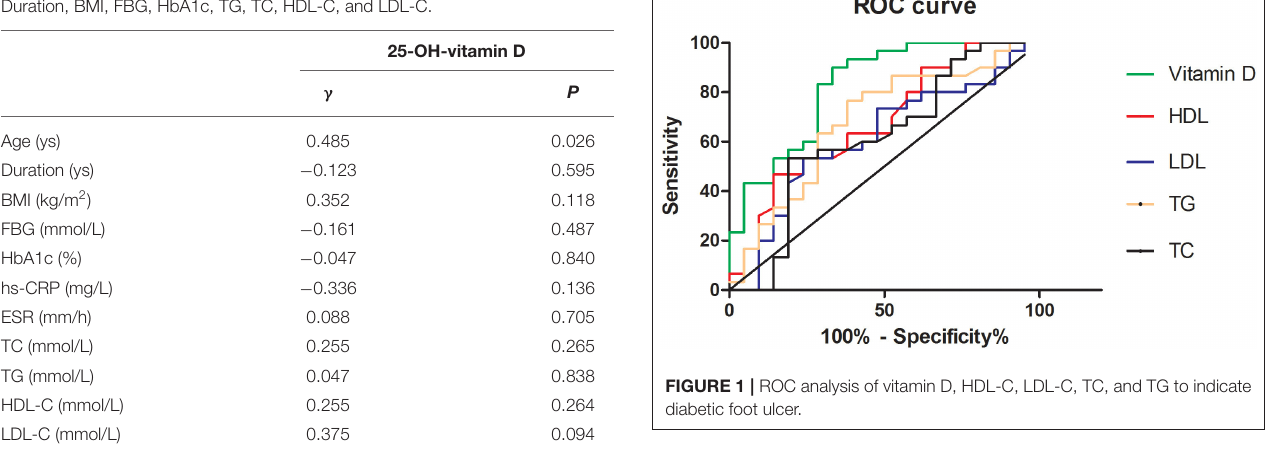
TABLE 2 | Spearman’s correlation coefficients of 25-OH-vitamin D with Age, Duration, BMI, FBG, HbA1c, TG, TC, HDL-C, and LDL-C.